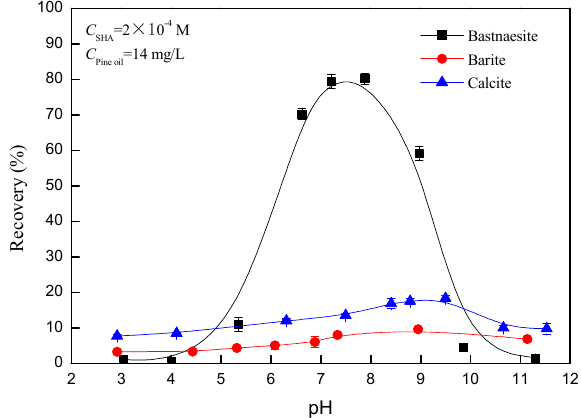
Figure 2. Flotation recoveries of the minerals as a function of pH.